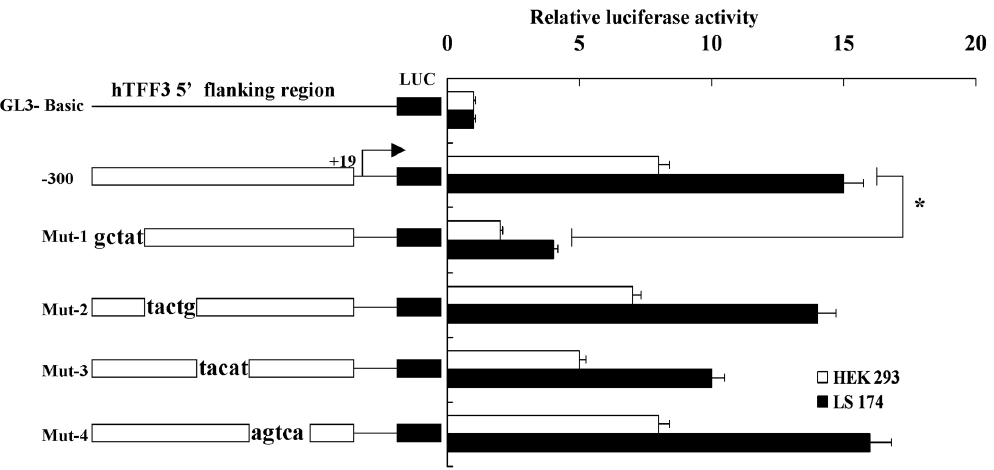
Figure 3. Mutation analysis of the hTFF3 promoter. Four consecutive hTFF3 promoter mutants were transfected into HEK 293 and LS-174T cells. The relative luciferase activity is presented as the ratio of firefly luciferase to Renilla luciferase. The results shown here were from three independent experiments. Data are presented as the mean 6 SD (*P , 0.05 vs . PGL3-300).